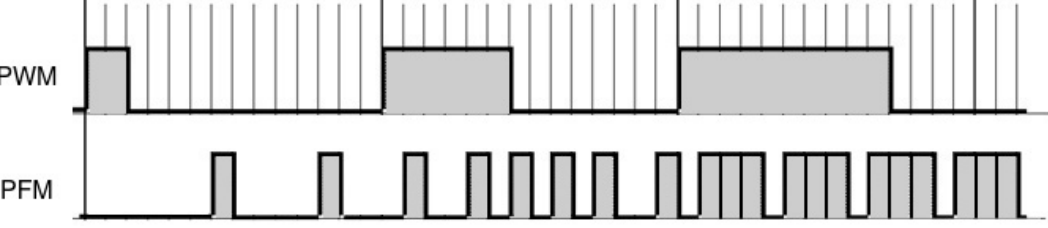
Figure 2. Comparison between PWM and Pulse Frequency Modulation (PFM) signals.